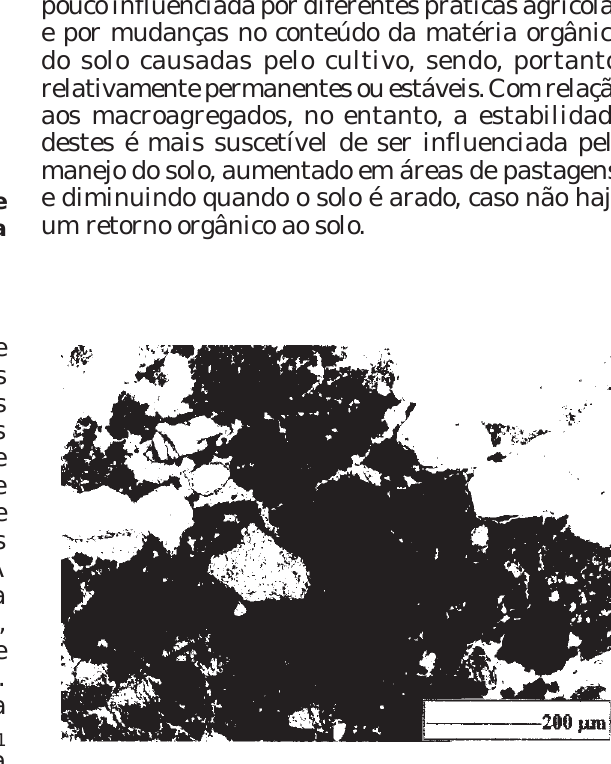
Figura 7. Microporos descontínuos e microfissuras não-comunicantes no horizonte AB do perfil com 18 anos de cultivo (XPL).